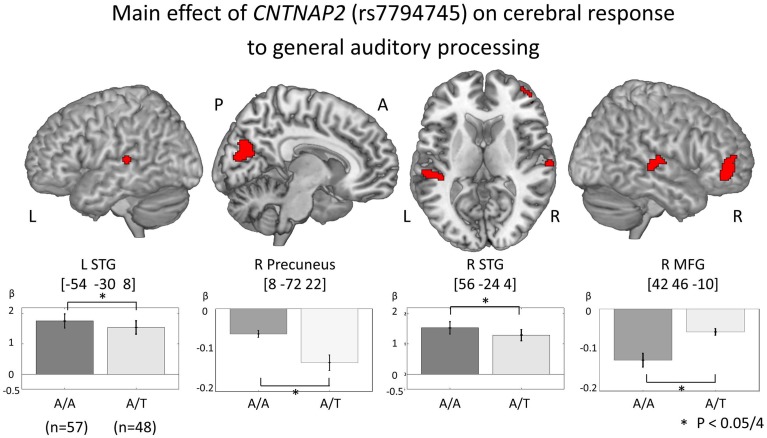
Main effect of CNTNAP2 (rs7794745) on cerebral response to general auditory processing. The results of the main effect of rs7794745 (A/A or A/T) in the analysis of full factorial design are shown (voxel level: p < 0.001, cluster level: p < 0.05/4, Monte–Carlo simulation). The bars show the distribution of beta values of brain function in general auditory processing at the MNI coordinates of peak activation (A/A: gray, rs7794745 A/T: light gray). Asterisk (*) shows a significant rs7794745 effect (A/A and A/T) with Bonferroni correction in 4 ROIs (p < 0.05/4). Abbreviations: L, left; R, right; A, anterior; P, posterior.